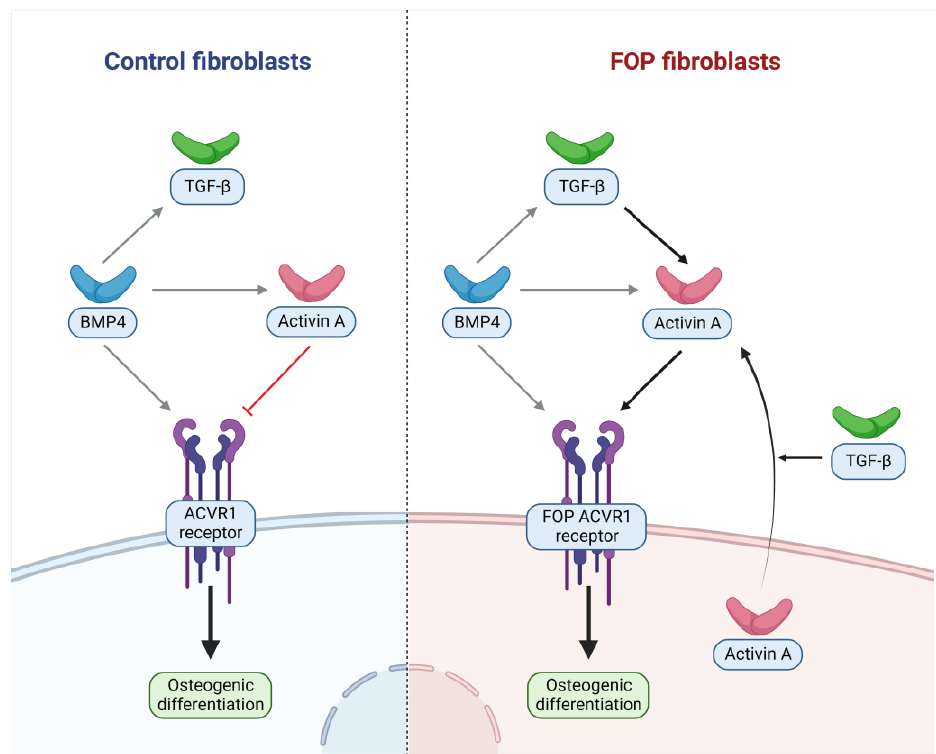
Figure 6. Schematic summary of main cytokine interactions with fibroblasts. TGFβ1 and BMP4 stimulation lead to increased Activin A production in FOP fibroblasts. In control fibroblasts Activin A production is increased less following exposure to BMP4 and not increased after TGFβ1 exposure. In both FOP and control, fibroblasts BMP4 leads to increased TGFβ1 production.